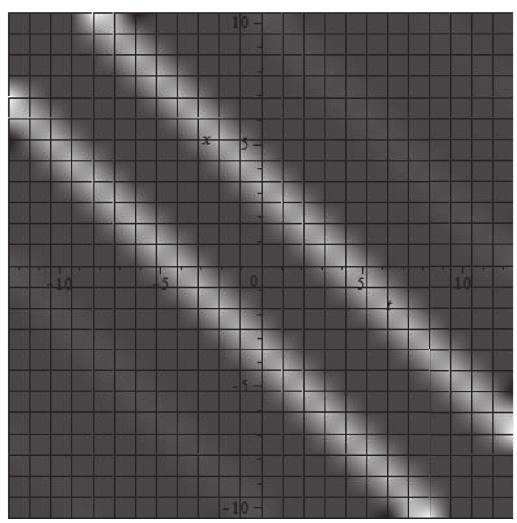
Figure 3: Density plot of (57) at σ � 10and α � 0 . 75. Figure 1: 3D plot for (57) with σ � 10and α � 0 . 75.